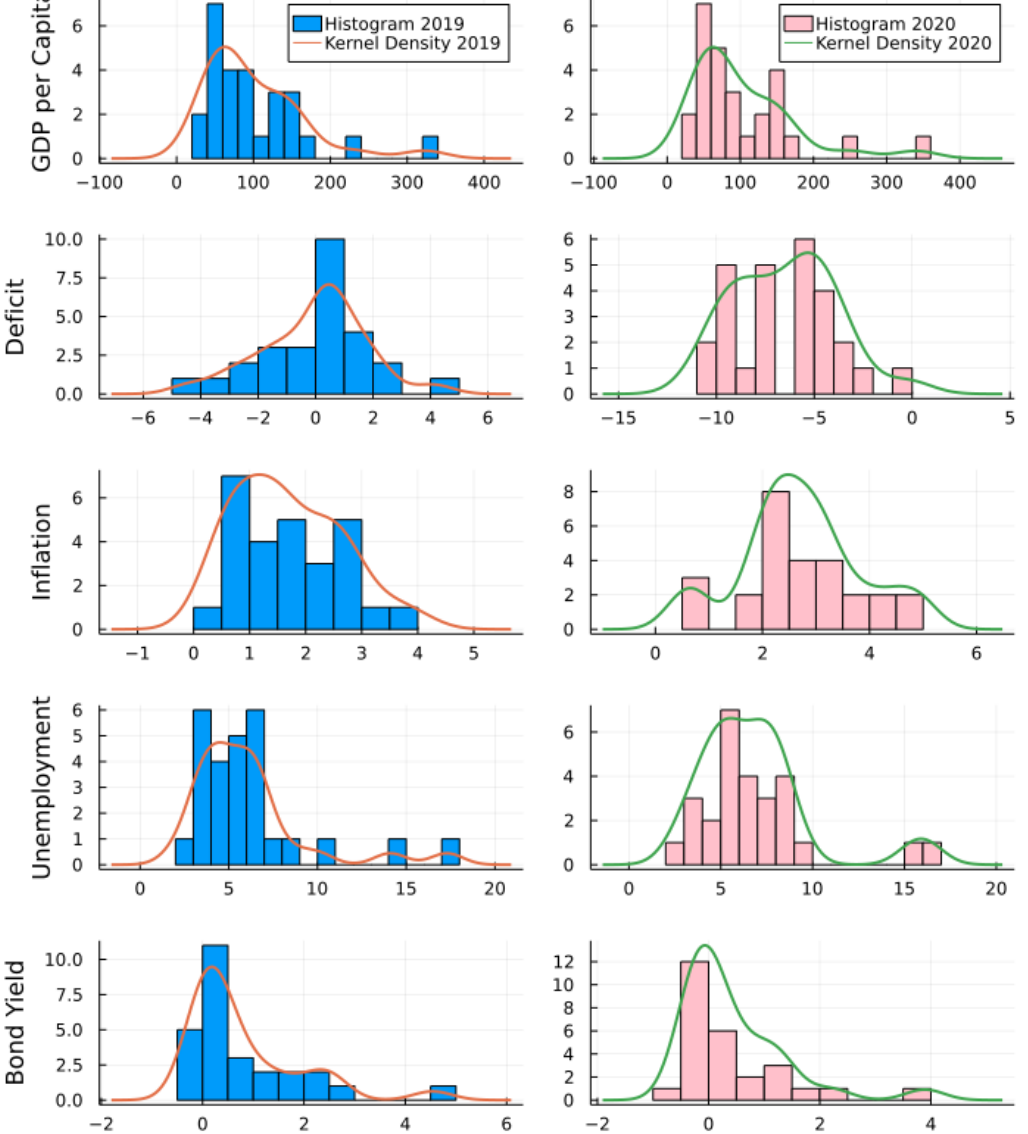
Figure A1. Histogram and Kernel densities: Left-hand panels represent the data of 2019 for each macroeconomic variable. Right-hand panels represent the data of 2020 for each macroeconomic variable. Source: Eurostat